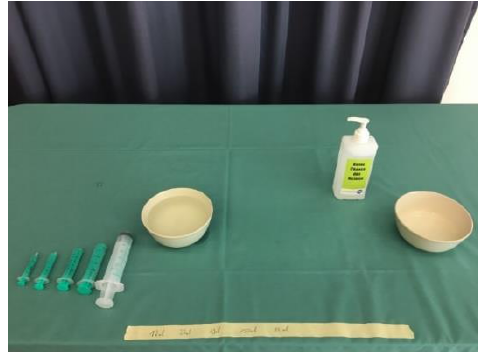
Figure 2: Spatial arrangement of the stimuli at the beginning of the handling